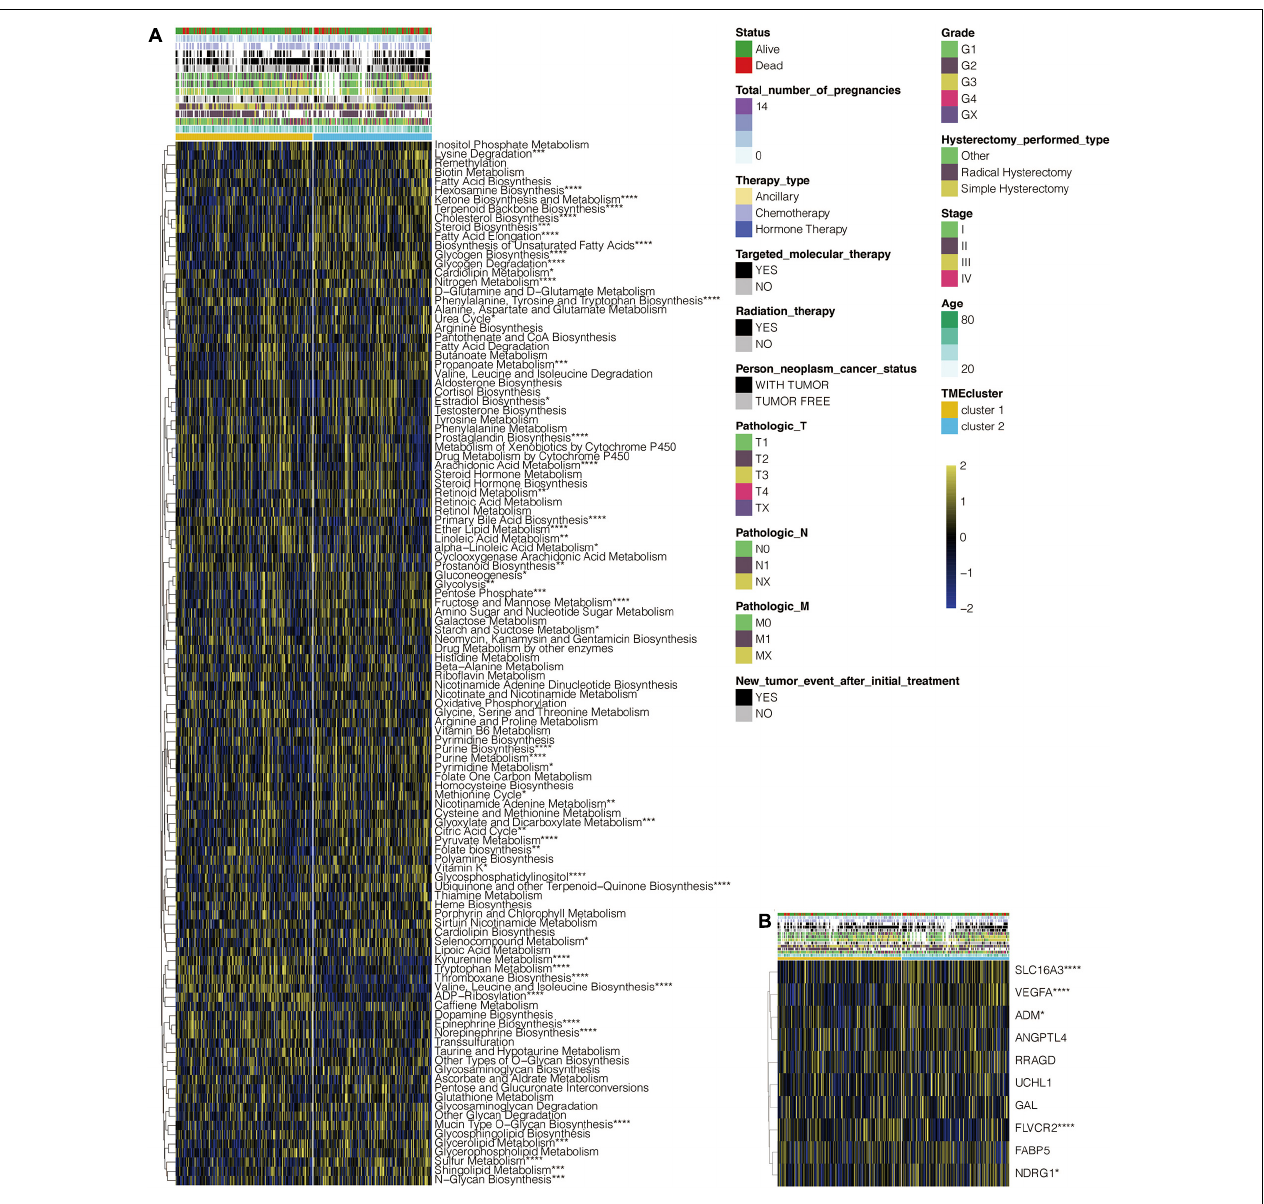
FIGURE 2 | Functional annotation of TME clusters. (A) Heatmap depicting the correlation of TME clusters and metabolic pathways. (B) Heatmap depicting the correlation of TME clusters and hypoxia-related gene signatures. *, P < 0.05; **, P < 0.01; ***, P < 0.001; ****, P < 0.0001; ns, not statistically